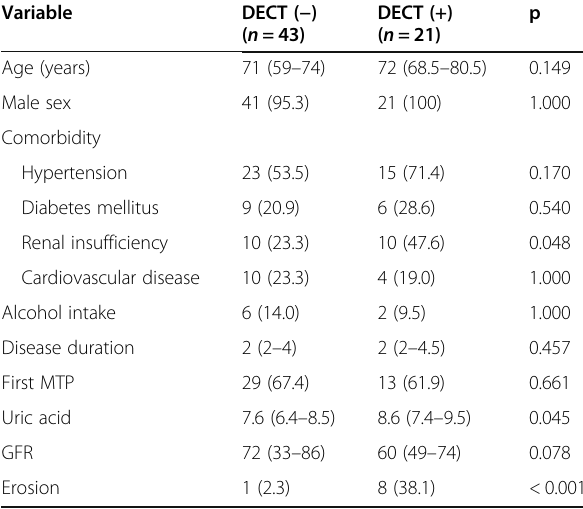
Table 3 Baseline characteristics of the patients with clinical diagnosis of gout (first